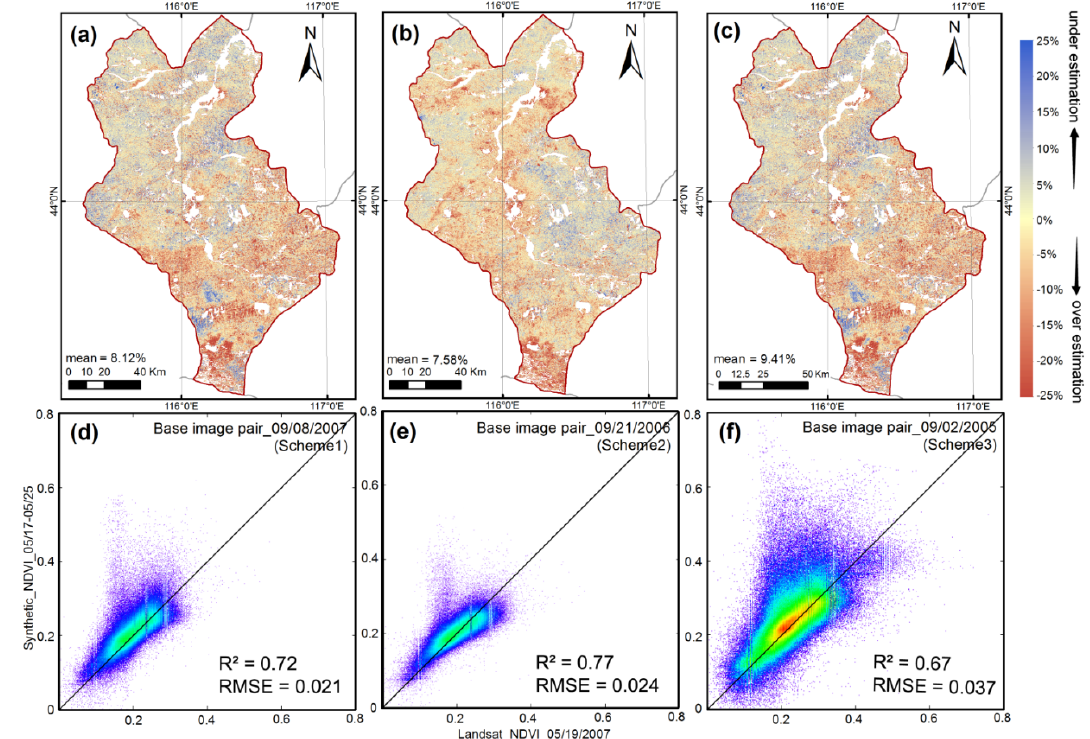
Figure 4. Difference maps and scatter plots between the observed Landsat NDVI images (taken 19 May 2007) and the synthetic NDVI images (taken during 17–24 May 2007) predicted by (Left) ( a , d ) Scheme 1; (Middle) ( b , e ) Scheme 2, and (Right) ( c , f ) Scheme 3.